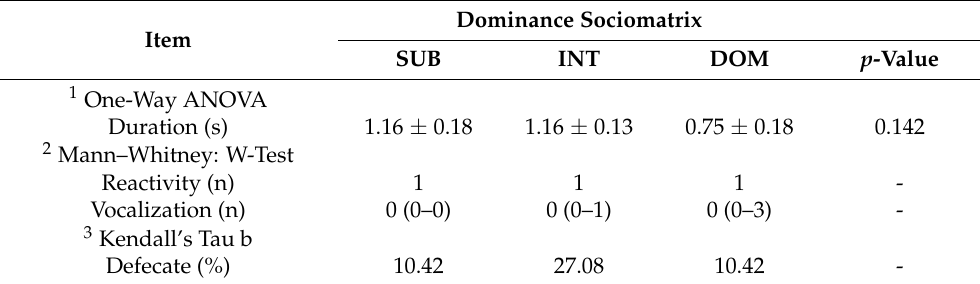
Table 4. Data from backtest according to the dominance sociomatrix classification.